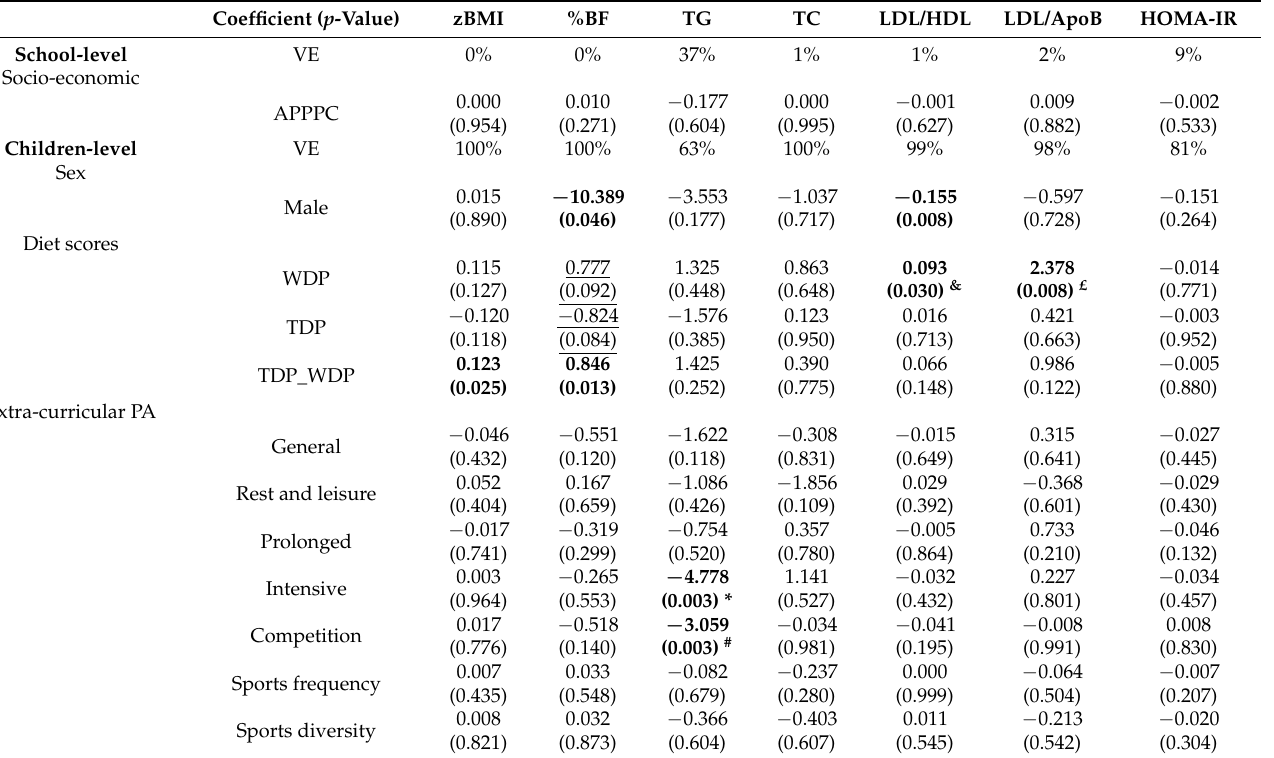
Table 5. Independent associations ( p -value) between school- and child-level variables with zBMI, %BF, and metabolic risk factors through multilevel